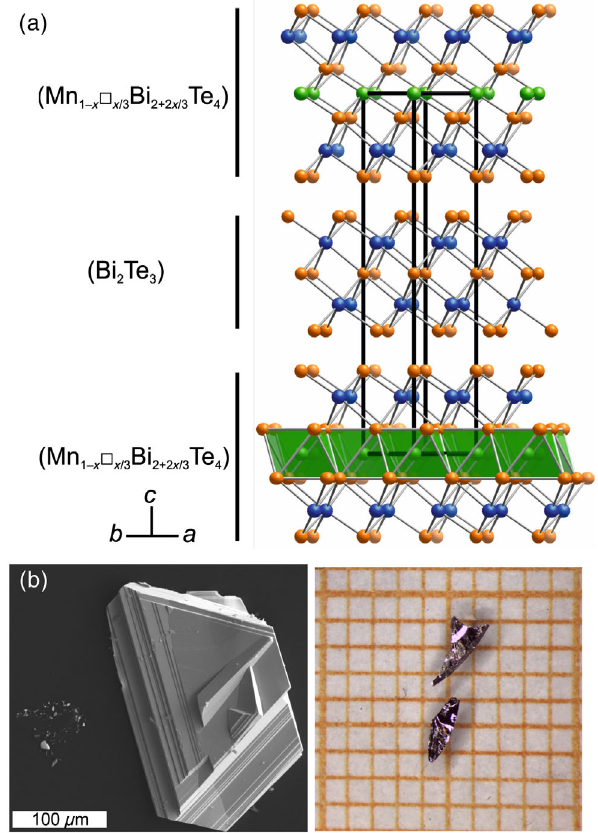
FIG. 1. (a) Crystal structure of Mn 1 − structure type) with alternating (Bi 2 Te 3 ) and (Mn 1 − Te 4 ) blocks. Mn atoms are shown in green; Bi in blue; Te in orange. (b) As-grown crystals with the experimental composition (EDX) Mn 0 Bi 4 Te 7 . 8 ð 1 Þ . 3 ð 1 Þ